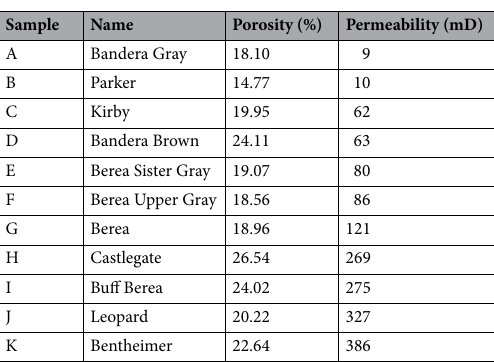
Table 1. List of sandstone rock samples used in our study and their respective properties. Sample labels A–K are listed in increasing order of permeability. We estimate the experimental error to be ± 0.5% for porosity and ± 10% for permeability, respectively 15